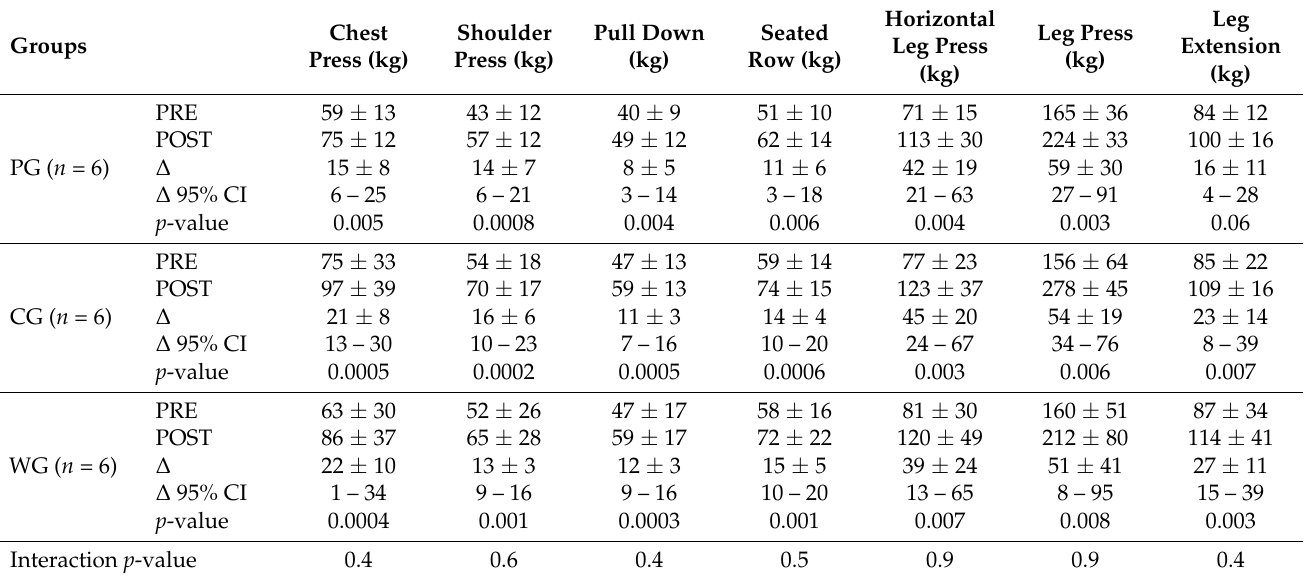
Table 4. Maximal strength measurements before (PRE) and after (POST) an 8-week resistance training program in the placebo (PG), chia flour (CG), and whey protein (WG) group.